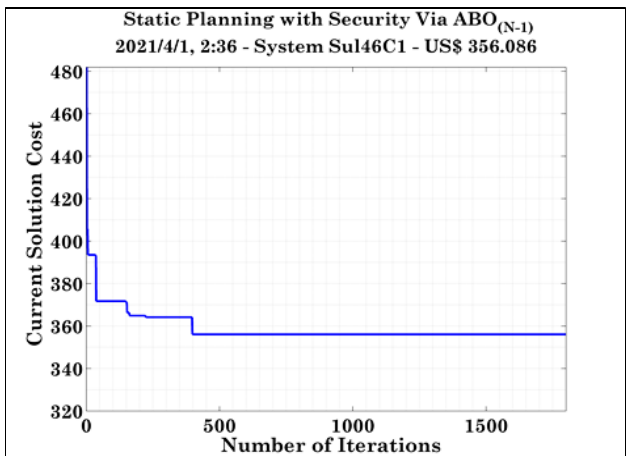
Figure 11: SB -46/79 system - Cost evolution of the best solution. Source: ABO (N-1) Optimizer,